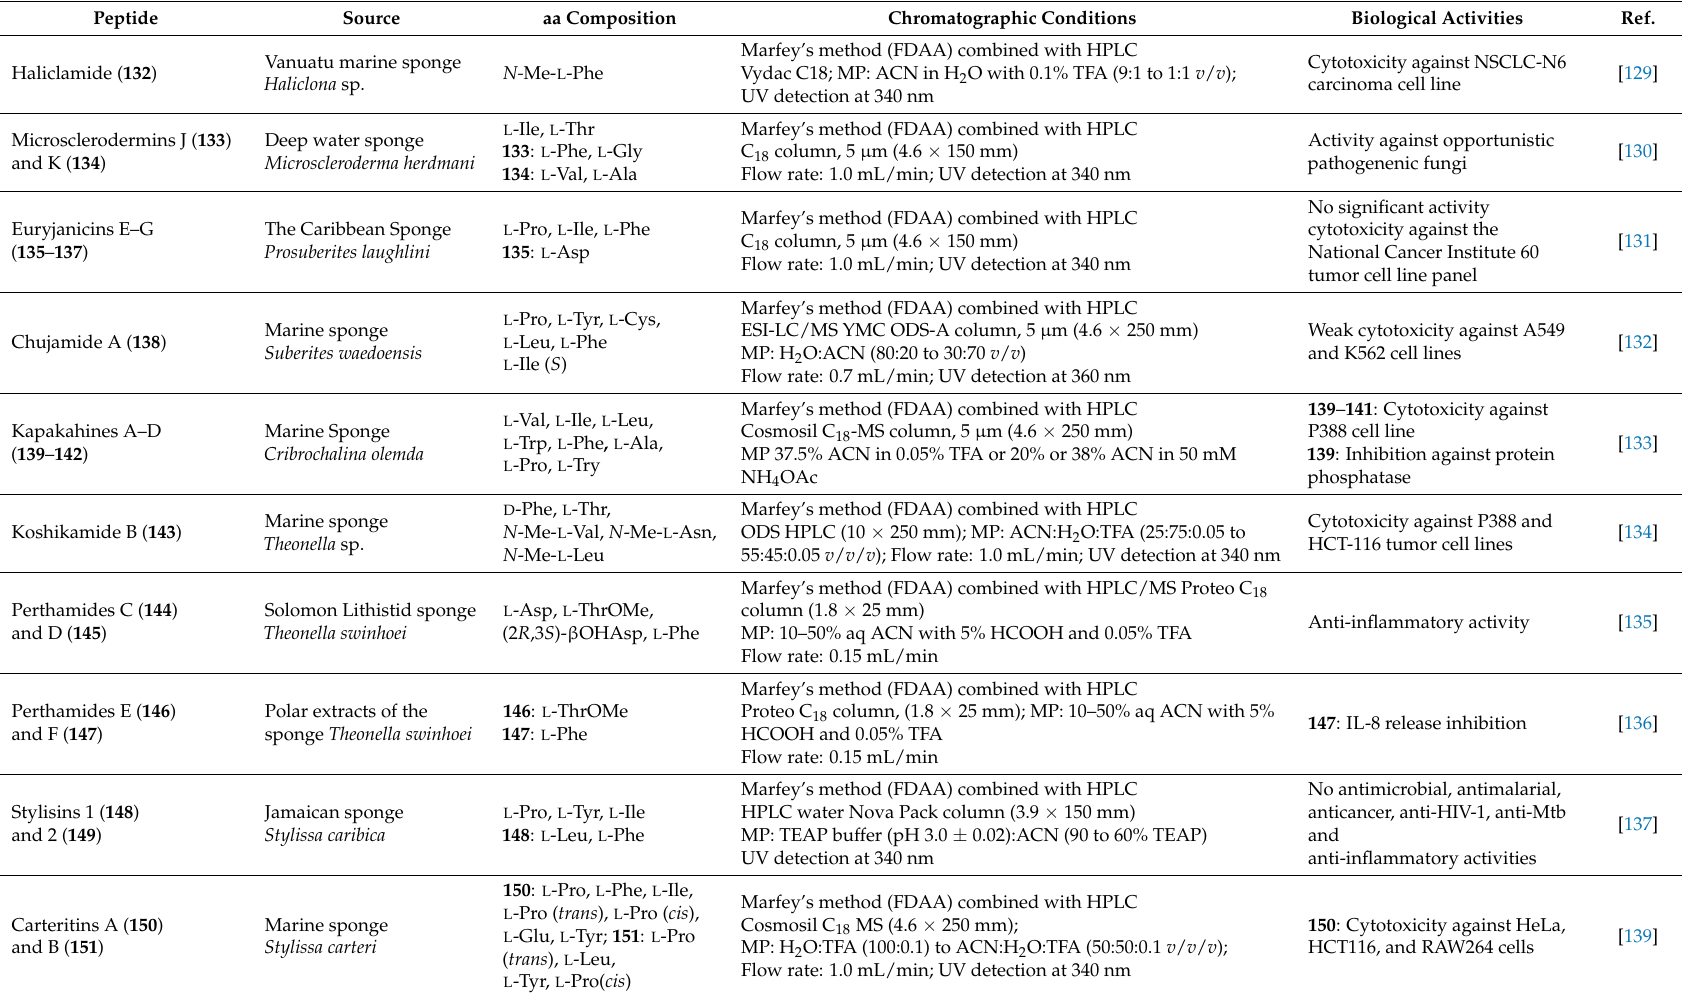
Table 6. Cyclic peptides from marine